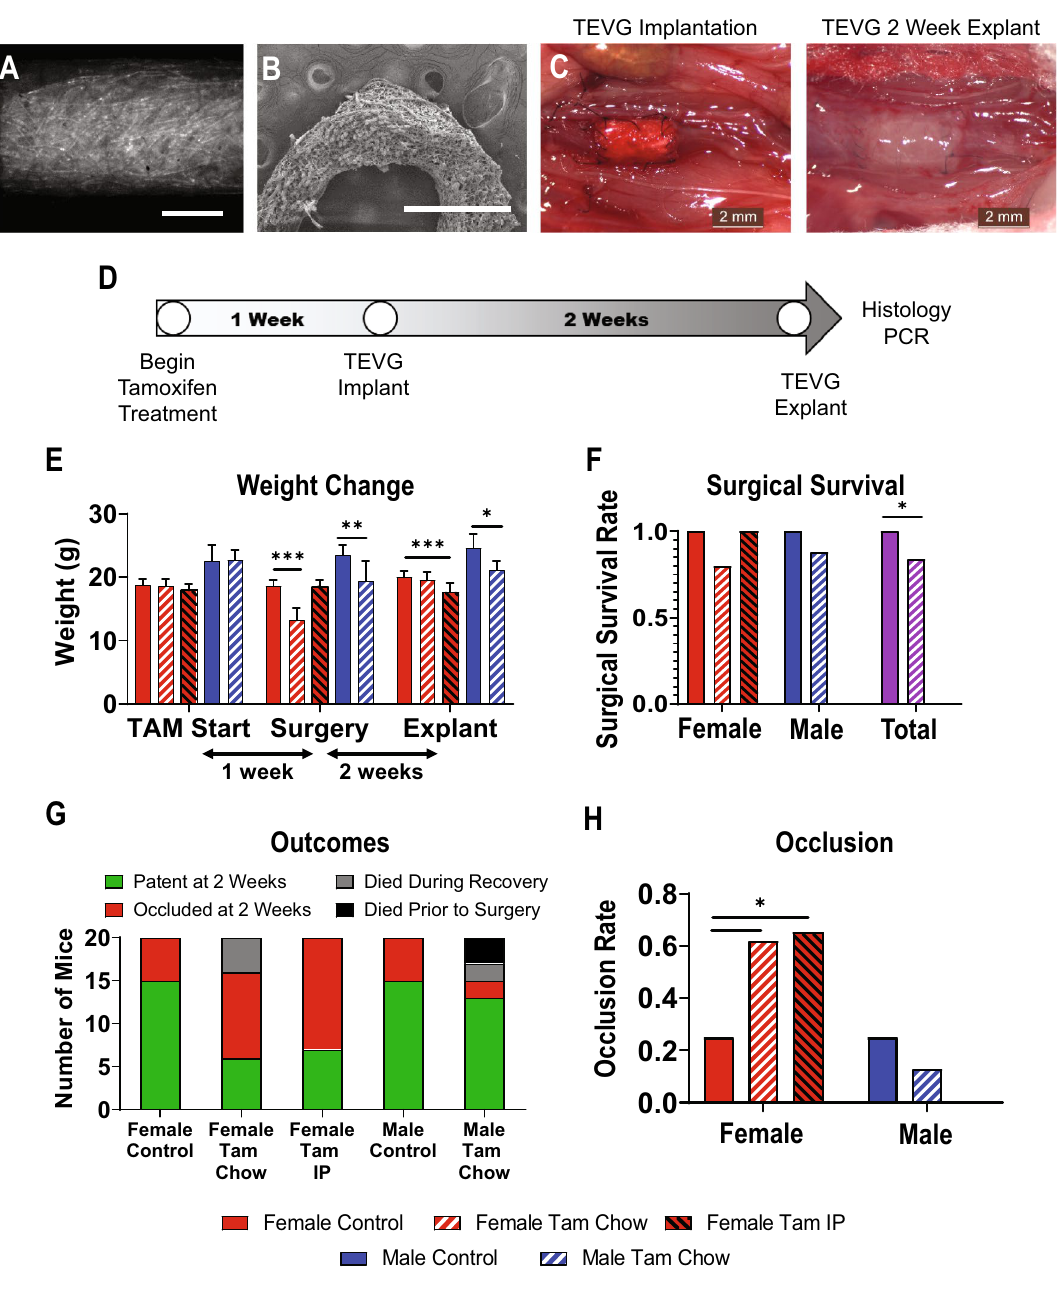
Figure 1. Experimental Overview and Outcomes. Transverse ( A ) and cross-sectional ( B ) view of the TEVG. ( C ) IVC interposition TEVG at implantation (Left) and 2-week explantation (Right). ( D ) Timeline of tamoxifen treatment, implant, and explant. ( E ) Survival and TEVG patency of all experimental animals. ( F ) Surgical survival rate of mice on control diet, tamoxifen chow, and IP tamoxifen injection. ( G ) Occlusion rate of TEVGs at explant. ( H ) Weight of animals measured at tamoxifen start date, date of surgery, and explant at two weeks post-implantation. Scale bars = 500 µm ( A and B ), 2 mm ( C ). N = 15–20 for weight measurement and compared statisticallyusing t-tests. N = 15–20 for occlusion rate and compared using Fisher’s exact test. * p < 0.05, ** p < 0.01, *** p <